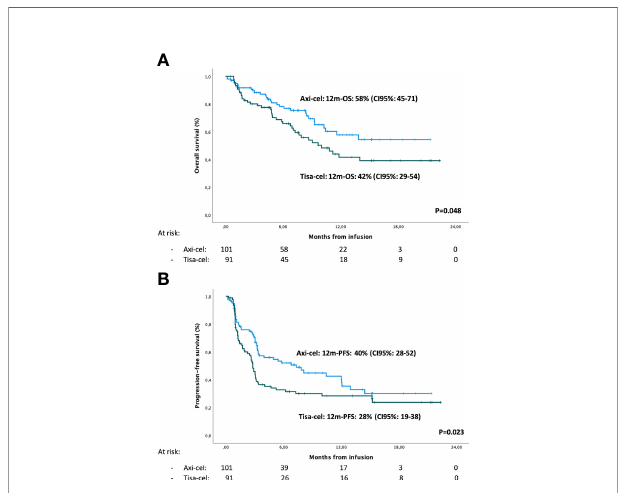
FIGURE 3 | Overall survival (A) and progression-free survival (B) in axi-cel and tisa-cel